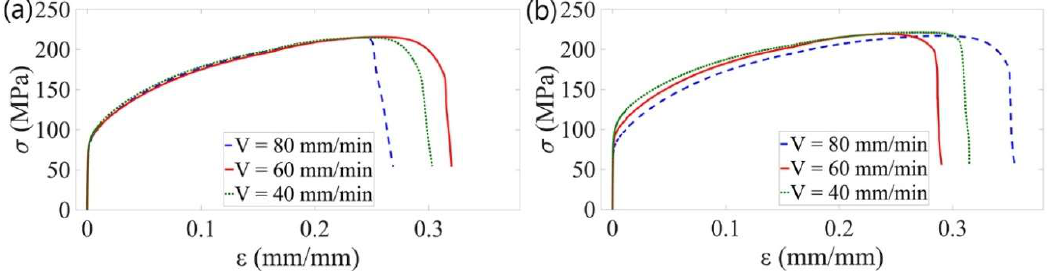
Figure 9. Tensile curves of FSW joint specimens produced with rotary speed ω = 580 rpm and traverse speed V = 80 mm / min: ( a ) orientation L; ( b ) orientation T.